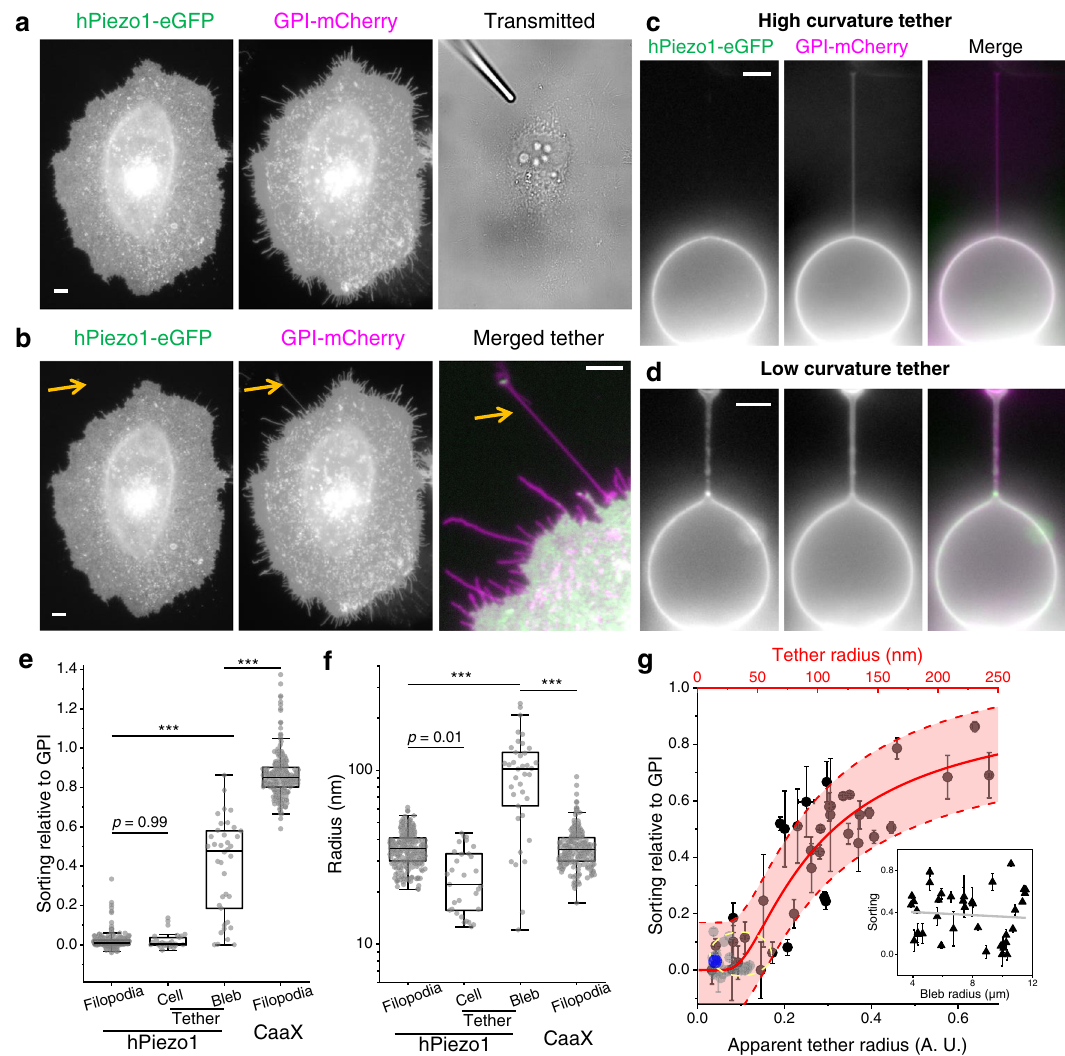
Fig. 2 | Sorting ofPiezo1 onmembranetethers. a Fluorescenceimages of a HeLa cell co-expressing hPiezo1-eGFP (left) and GPI-mCherry (middle). The transmitted light image (right) shows the position of a motorized micropipette (fused-tip) in contactwiththecellbeforetetherpulling. b FluorescenceimagesoftheHeLacellin ( a ) after a 20 µ m tether was pulled out (arrow). The tether region is merged and contrast-adjusted on the right. c , d Fluorescence images of tethers pulled from membrane blebs on HeLa cells co-expressing hPiezo1-eGFP (left) and GPI-mCherry (middle). Merged images shown on the right. Signi fi cantly less Piezo1 signals were observedonthetetherfromtensebleb( c )comparedtothetetherfrom fl oppybleb ( d ). All fl uorescence images are shown in log-scale to highlight the dim tether. All scale bars are 5 µ m. Full images of the cell in ( c ) and ( d ) are shown in Fig. S8. e , f Sorting of hPiezo1 ( e ) and radii of tethers ( f ) pulled from cell membranes (Cell, n =31cells;asin a – b )andmembraneblebs(Bleb, n =38blebs;asin c – d )relativeto